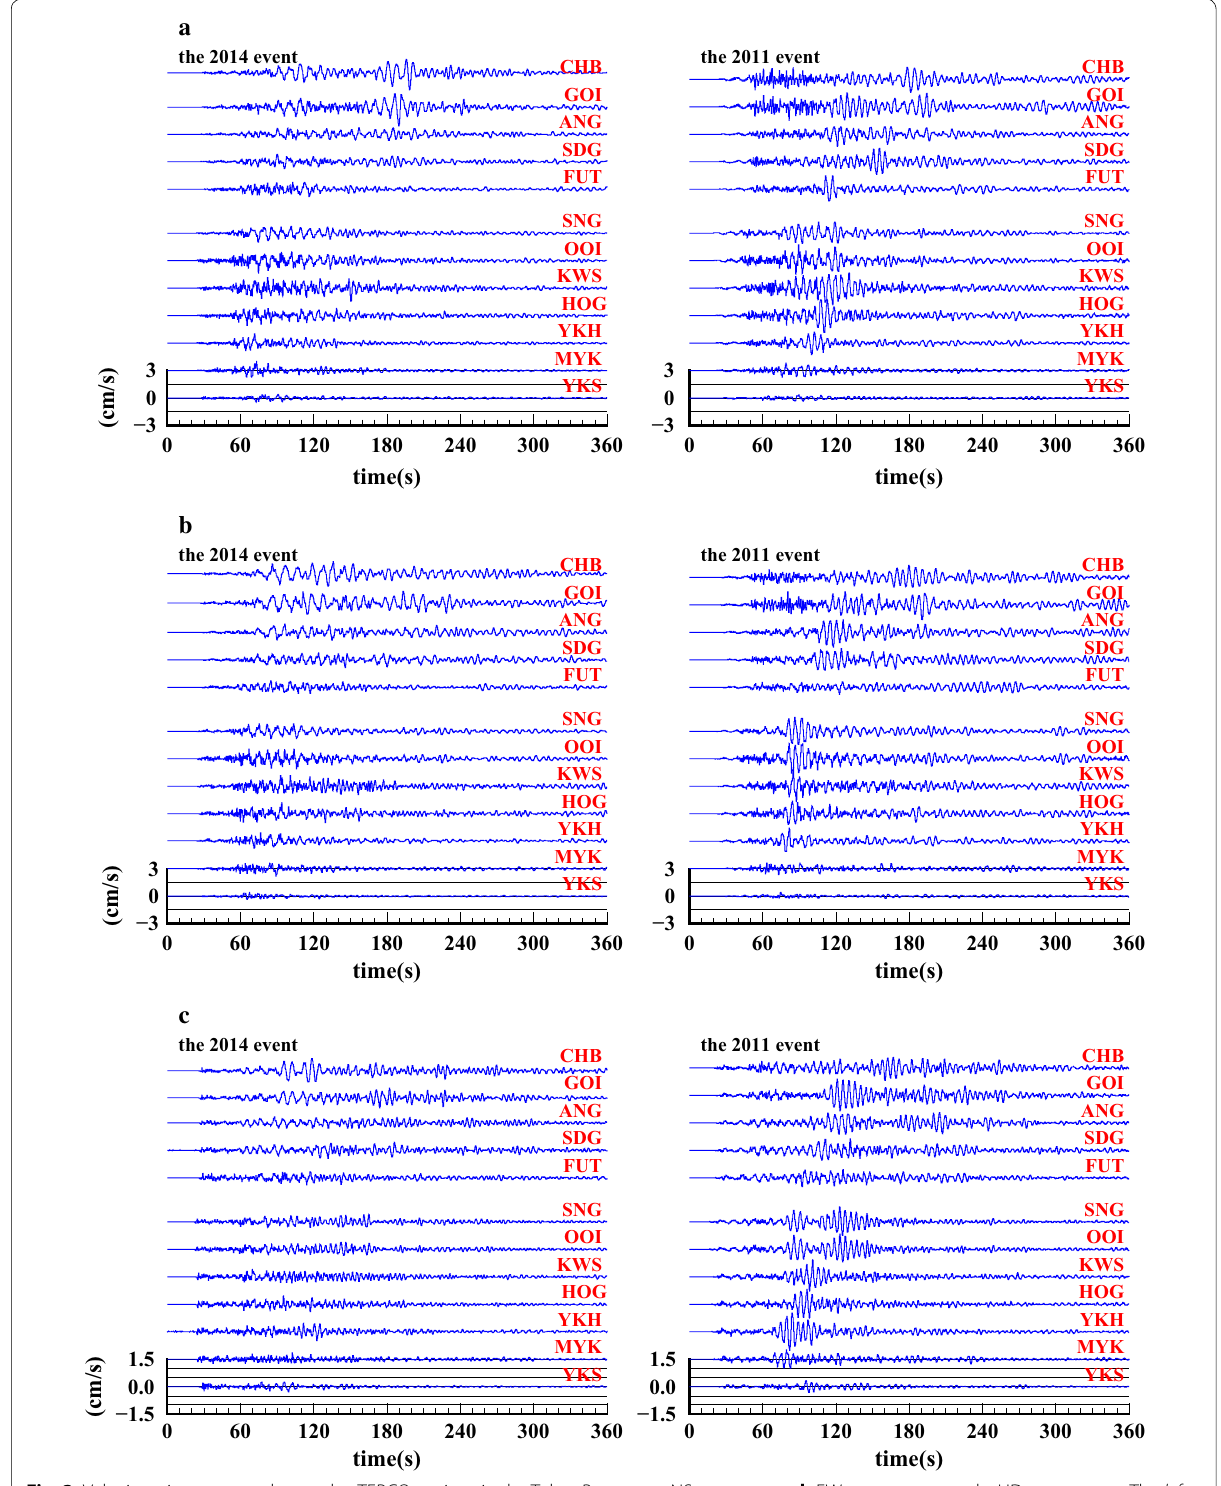
Fig. 3 Velocity seismograms observed at TEPCO stations in the Tokyo Bay area, a NS component, b EW component, and c UD component. The left side shows the records for the 2014 event, and the right side shows the records for the 2011 event. Red characters associated with each trace indicate the station code. The location of each station is shown in Fig.